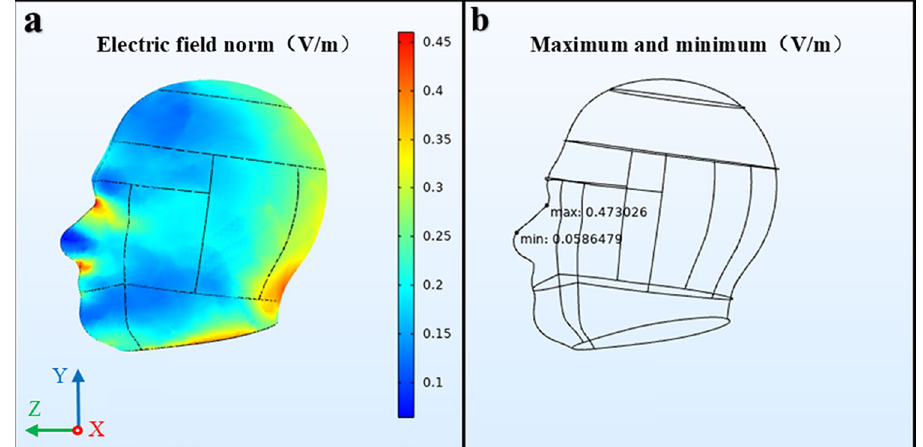
Figure 5. The multi-section electric field in the brain exposed to an EMP at 300 MHz. (a) The electric field norm, (b) the maximum and minimum electric field.